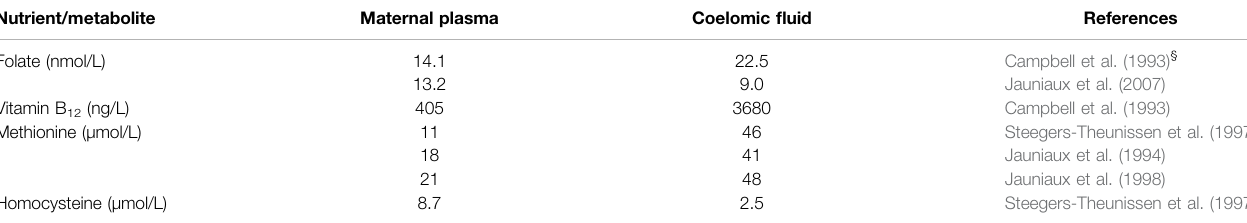
TABLE 1 | Folate, vitamin B 12 and methionine-related metabolites in maternal plasma and coelomic fl uid. Nutrient/metabolite Maternal